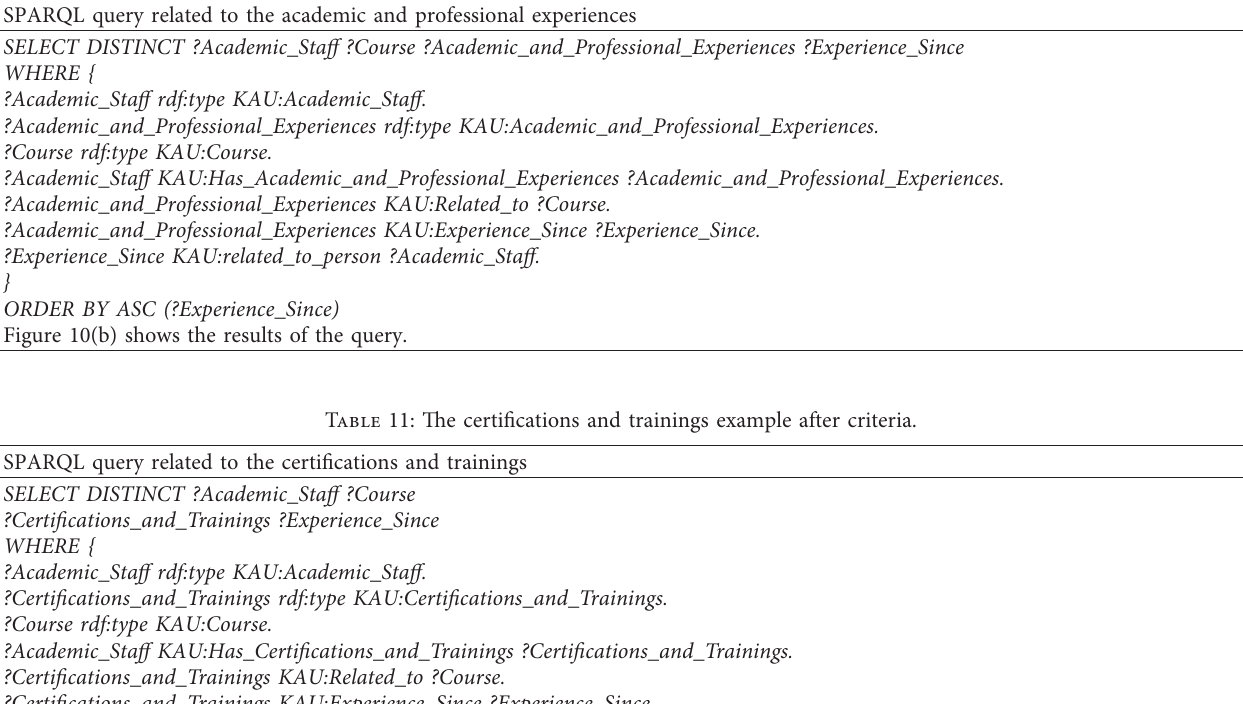
Table 10: The academic and professional experiences example after criteria.